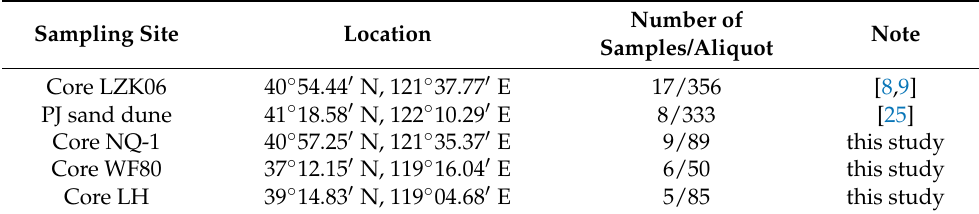
Table 1. Information of sampling sites and